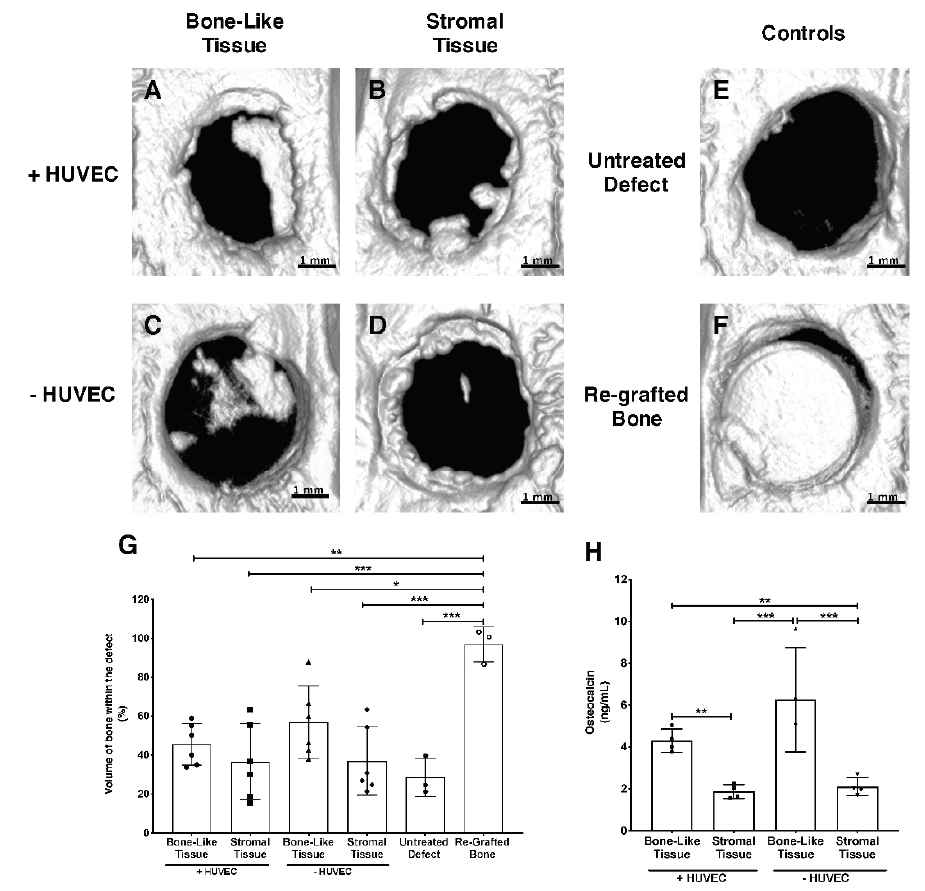
Figure 7. Micro-CT analysis of calvarial bone defect sites 12 weeks after tissue implantation and quantification of osteocalcin in explanted tissues. Micro-CT images of the bone defects treated with reconstructed bone-like or stromal tissues, in presence or absence of prevascularization ( A – D ). Untreated defect ( E ) and re-grafted bone ( F ) groups were used as controls to mimic the lack of intervention, or an autograft procedure, respectively. The bone is represented by the white structures on a black background at a threshold of 700. Scale bars, 1 mm. The percentage of bone volume at the implantation sites was quantified based on micro-CT scans ( G ). Osteocalcin quantification in tissue lysates from the explanted defect sites ( H ). Twelve weeks after implantation, prevascularized (+HUVEC) and non-prevascularized ( − HUVEC) bone-like tissue constructs contained elevated levels of human osteocalcin compared to stromal tissues but were not different from each other. Native rat bone was used to assess nonspecific binding between species for osteocalcin, which was considered background. One-way ANOVA with a Bonferroni’s multiple comparisons test, * p < 0.05, ** p < 0.01, *** p < 0.001.